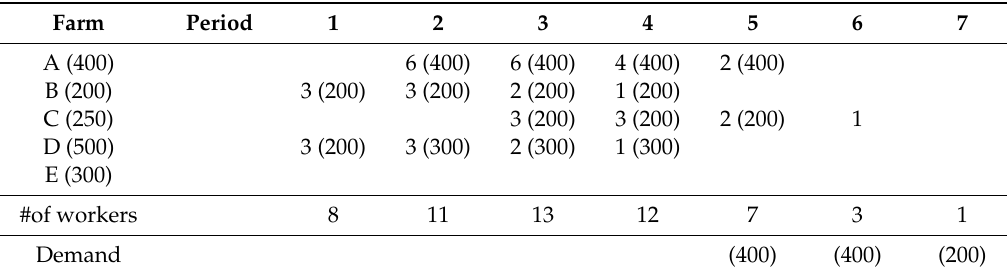
Table 1. Solution of the mathematical model generated by Lingo